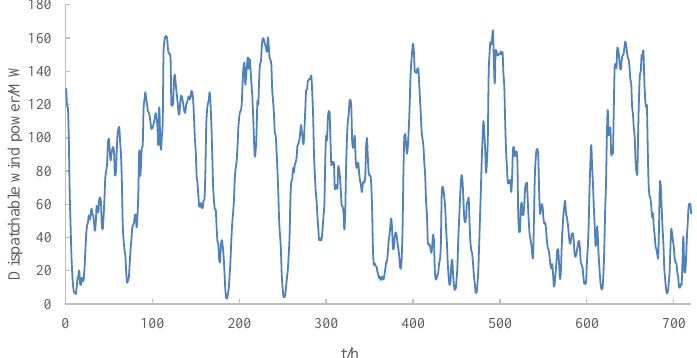
Figure 6. Typical available wind power for a